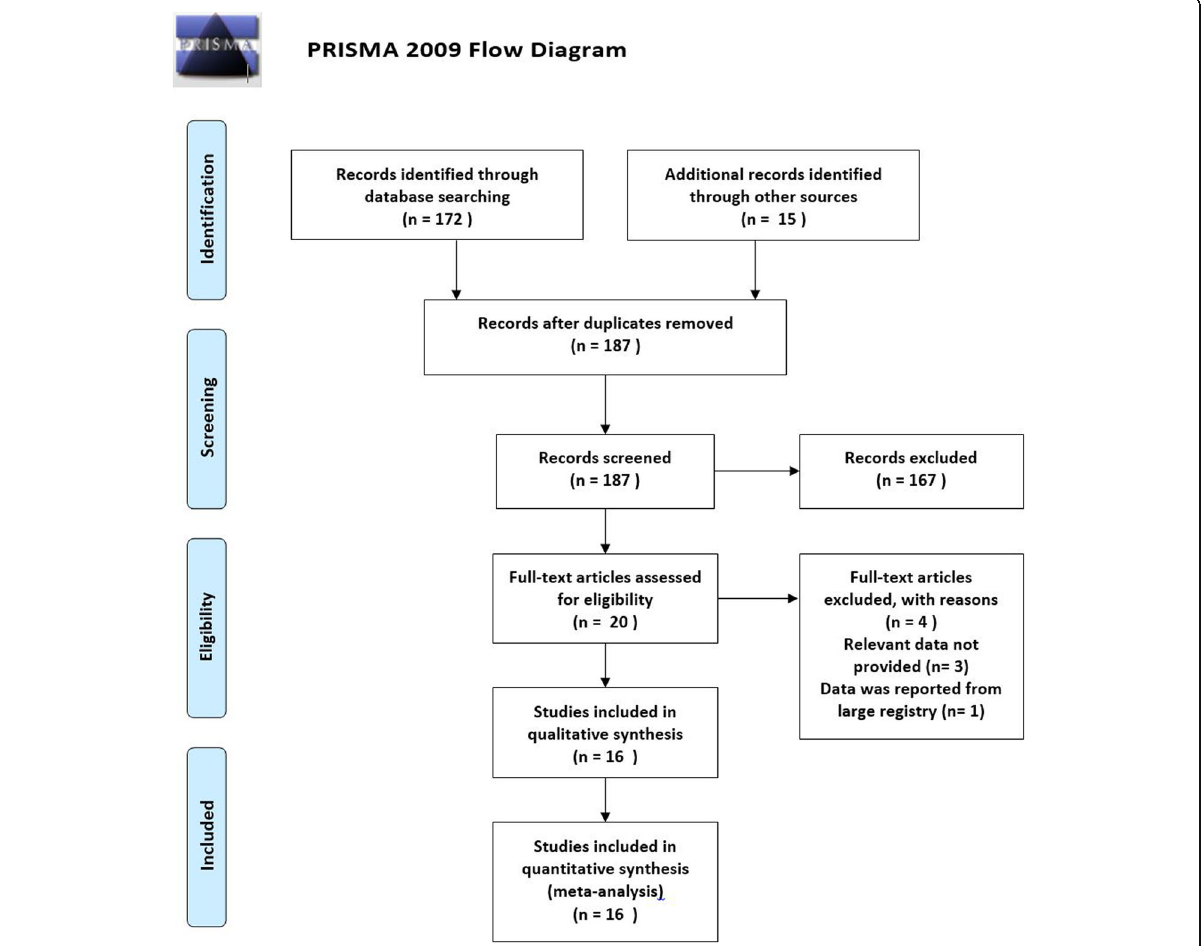
Fig. 1 PRISMA flow chart summarizing the literature